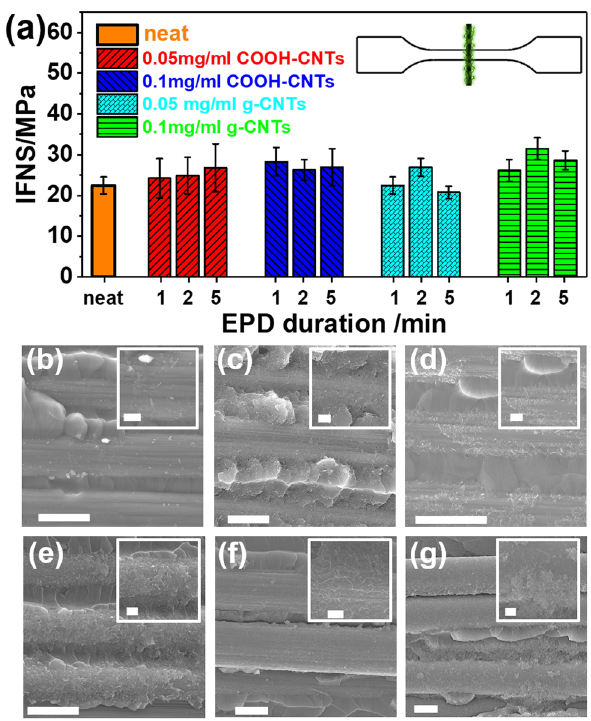
Figure 4: IFNS from fi ber enhancement under di ff erent nano fi ller depositions ( a ) and SEM images of g - CNTs ( b ) – ( d ) and C - CNTs EPD ( e ) – ( g ) treated TFBT sample with the concentrations of 0.1 mg/mL, applied voltage strength of 10 V/cm, and duration time of 1, 2, and 5 min. The scale bars of main and insert images are 5 and 1 µm,